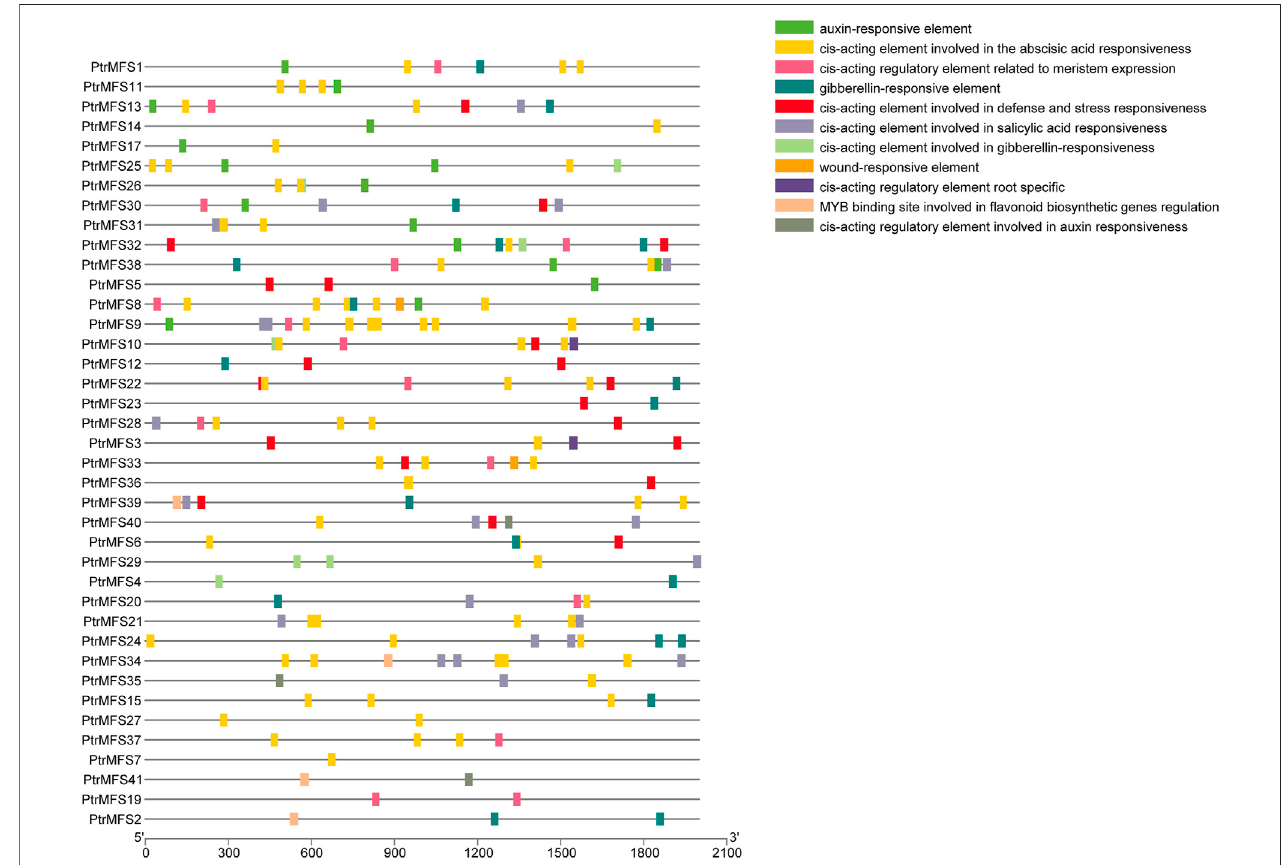
FIGURE 4 | Analysis of cis-acting elements in promoters of PtrMFS genes. The patterns in different colors represent different cis-acting elements.